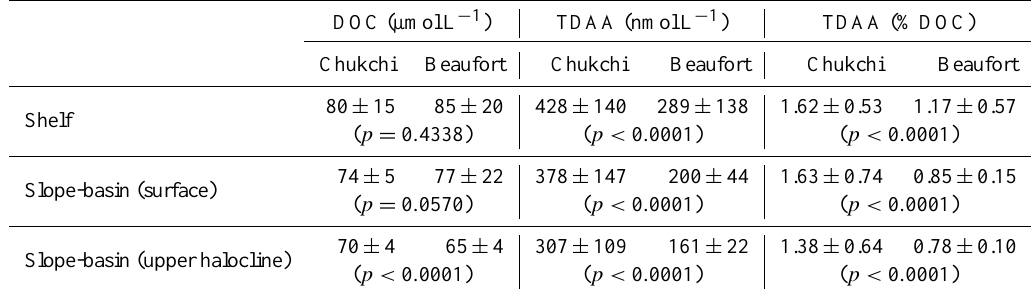
Table 3. Comparisons of the concentrations of DOC and TDAA, and TDAA yields in the Chukchi and Beaufort Seas ∗ (Mann-Whitney U